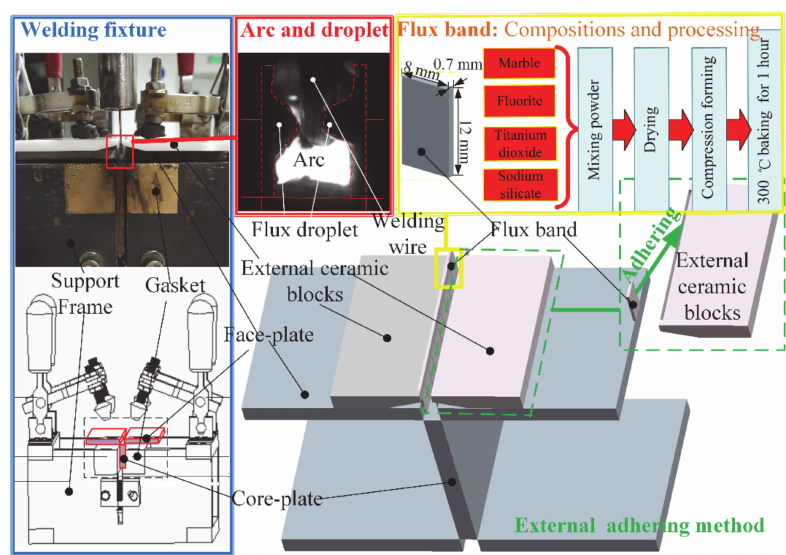
Figure 2. Dimensions of T-joint grooves.